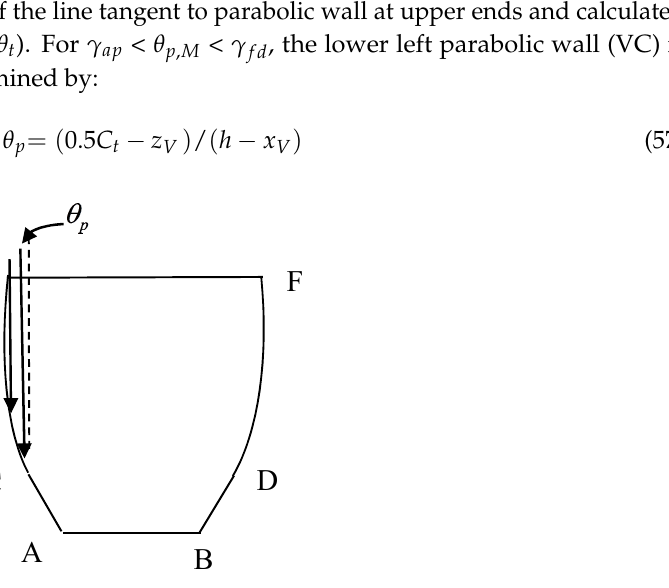
Figure 9. Irradiation situation of left parabolic wall when γ ap < θ p < γ fd Figure 9 . Irradiation situation of left parabolic wall when ap